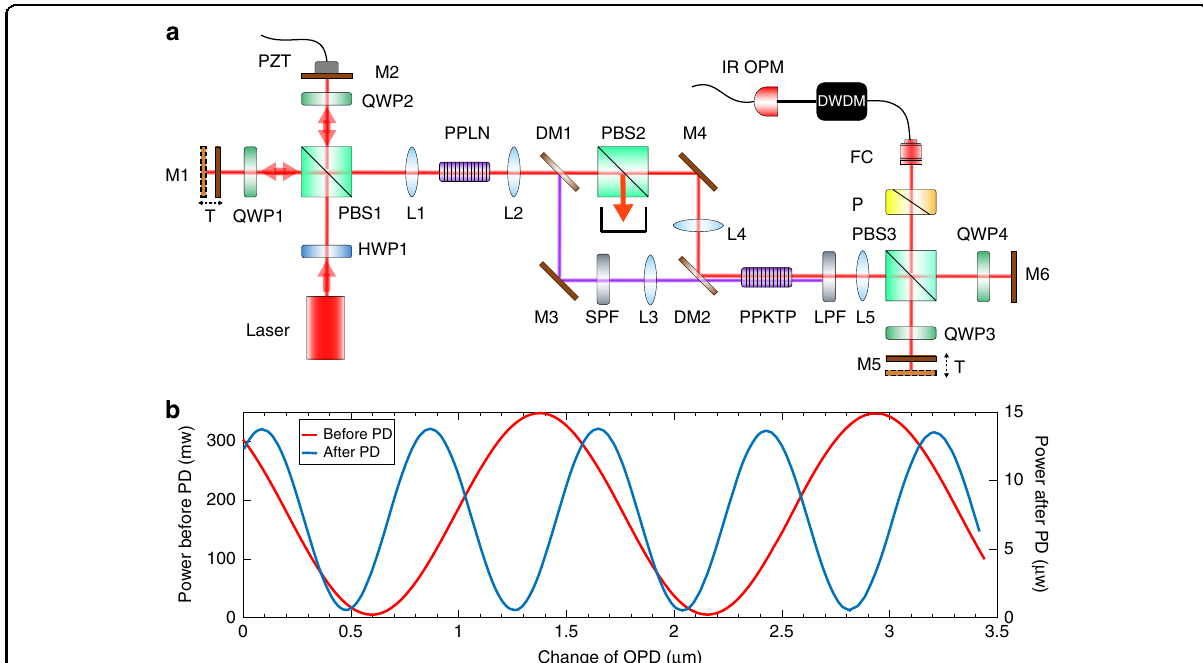
Fig. 4 Experimental setup and results. a Experimental setup used for phase doubling (PD) without frequency doubling. SPF: 1000 nm short pass fi lter; LPF: 1400 nm long pass fi lter; FC: fi bre collimator; CH22: channel 22 of a dense wavelength division multiplexing system with a centre wavelength of 1559.79 nm. b Measured optical power characteristics of interference before and after phase